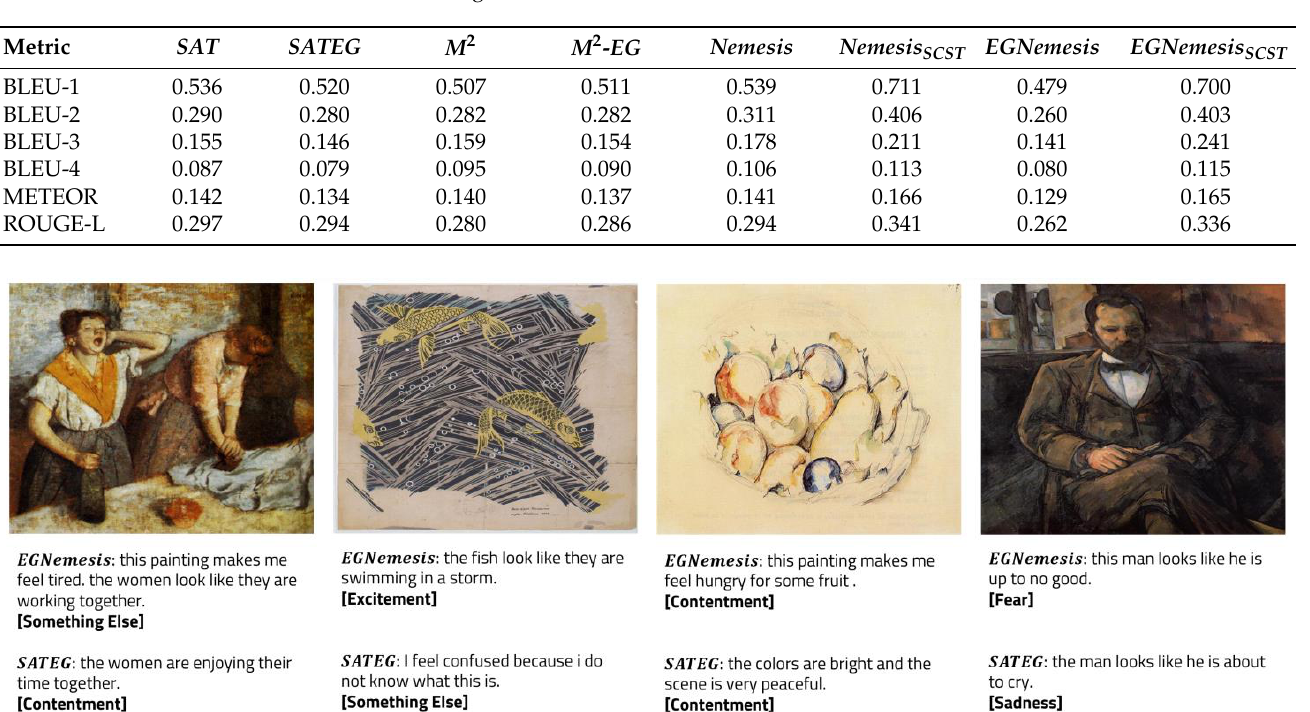
Table 6. Comparison of state-of-the-art results and Nemesis after both cross-entropy training and SCST fine-tuning.